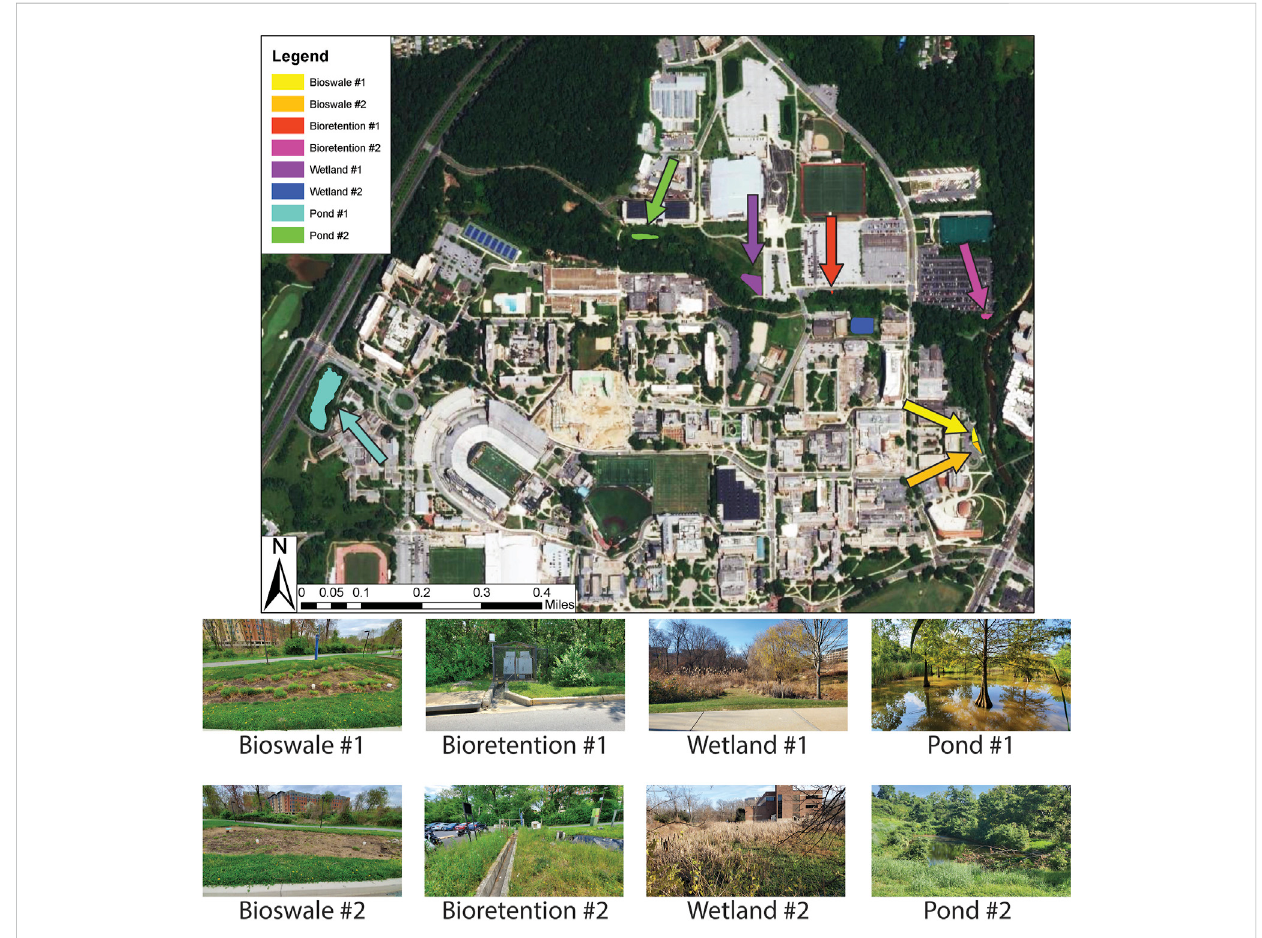
FIGURE 1 Stormwater management features sampled across the UMD campus. Duplicate bioswale, bioretention, wetland, and pond sites were